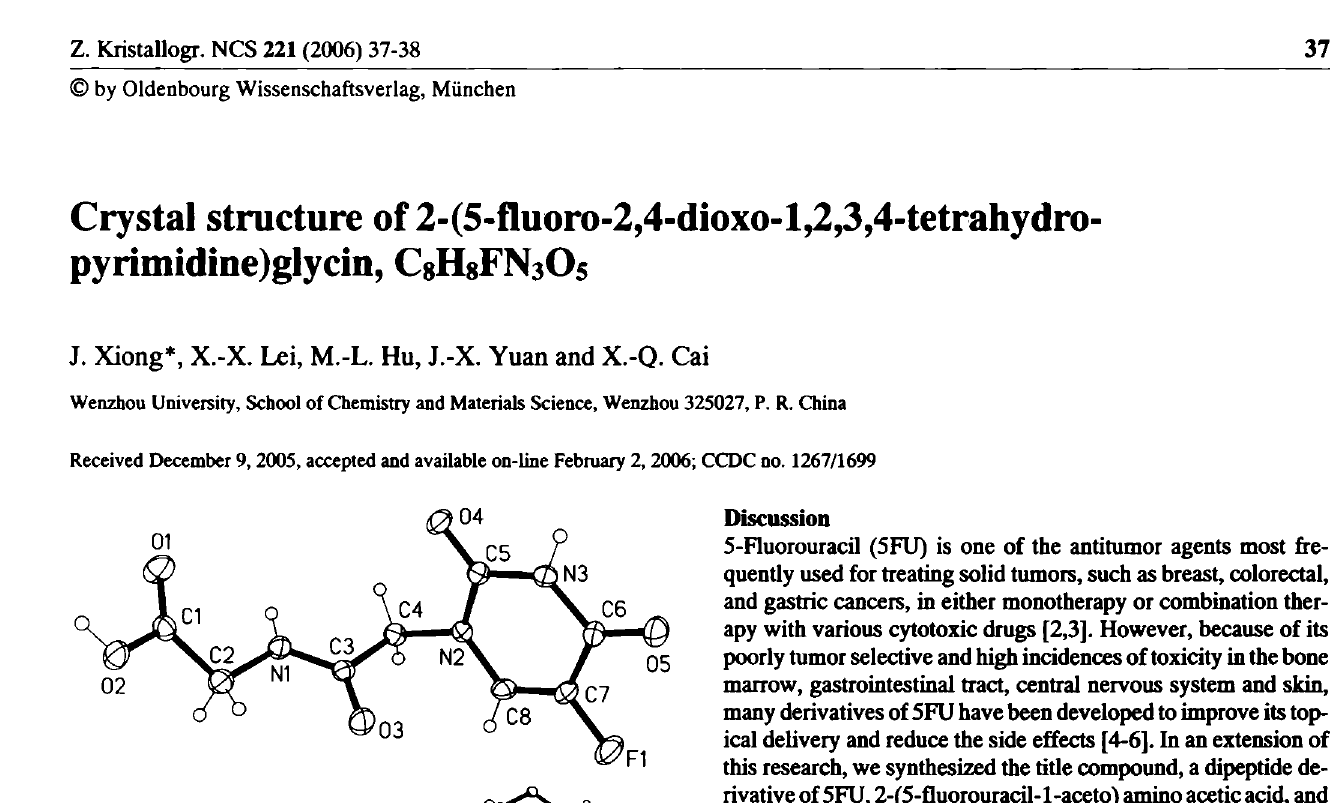
Table 1. Data collection and handling.